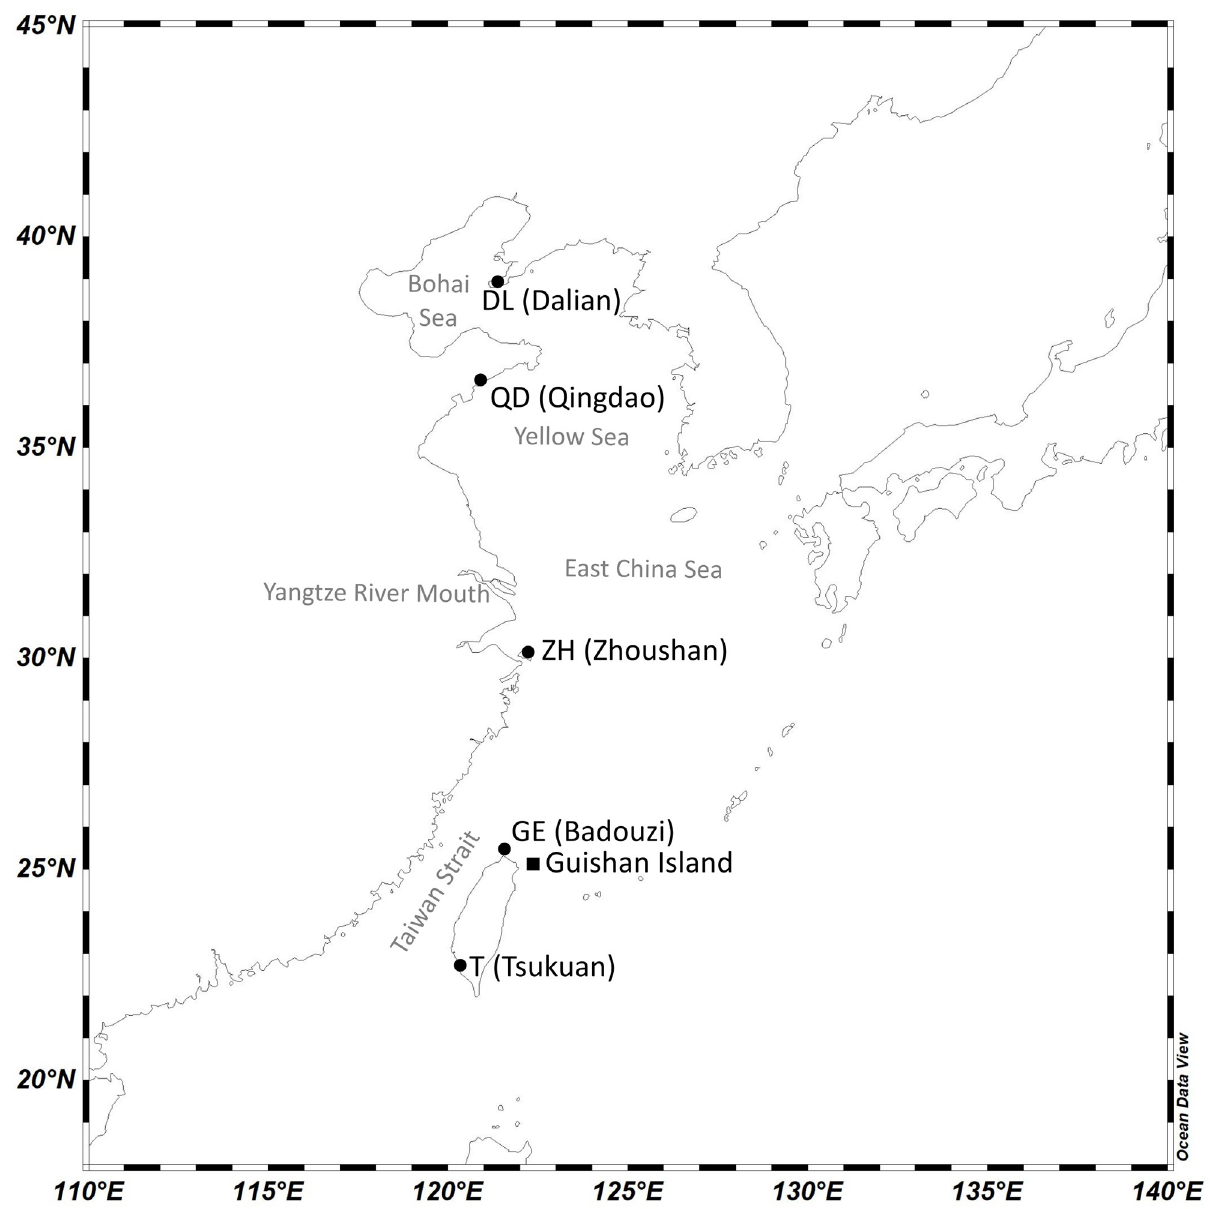
Fig 1. Map of the Northwest Pacific illustrating the sampling locations of T . japonicus for microsatellite study (circles) and RNA extraction (square). The details of sampling location and time are described in Table 1. The map was generated by Schlitzer, Reiner, Ocean Data View, odv.awi.de,